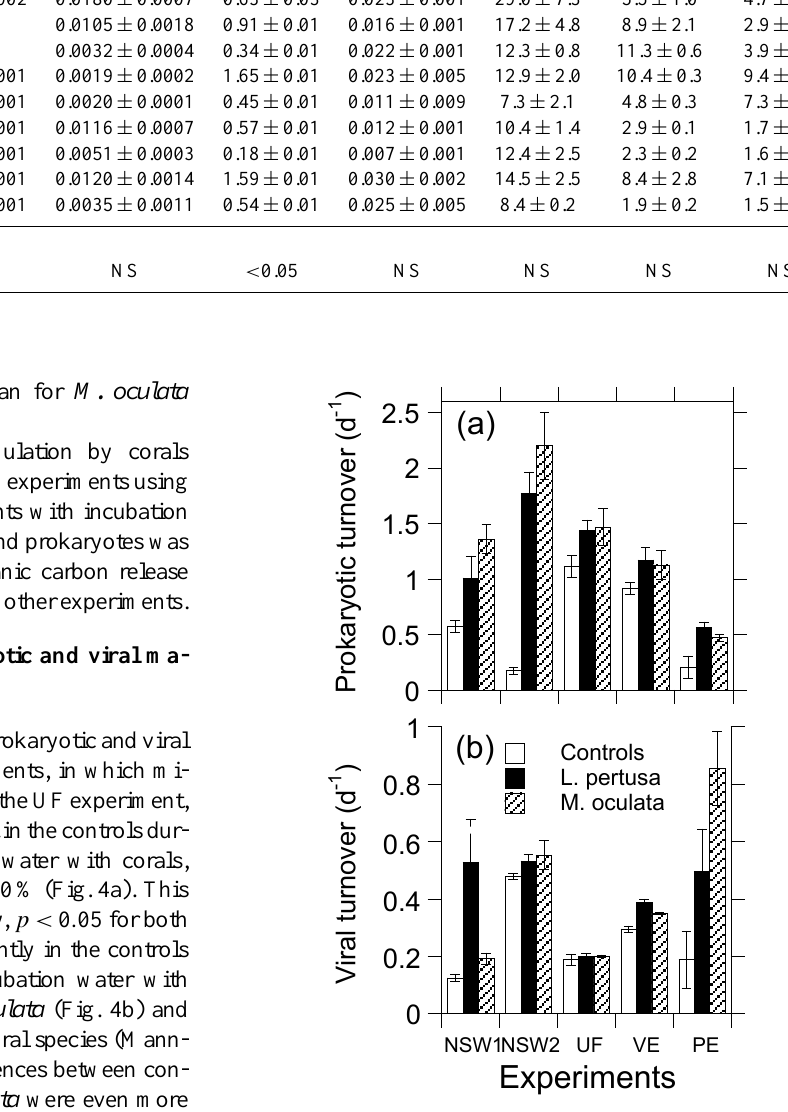
Fig. 3. Prokaryotic and viral turnover rates in the experiments. Data are given as averages ± SE of 3